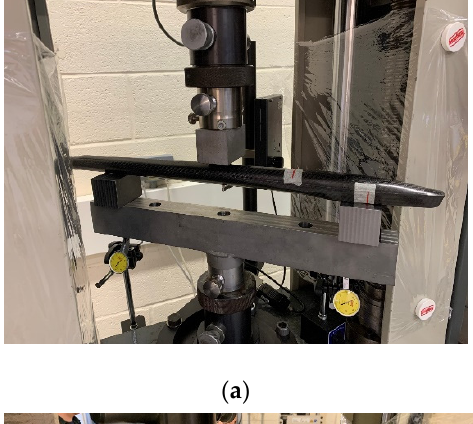
The test proceeded to the failure point of the